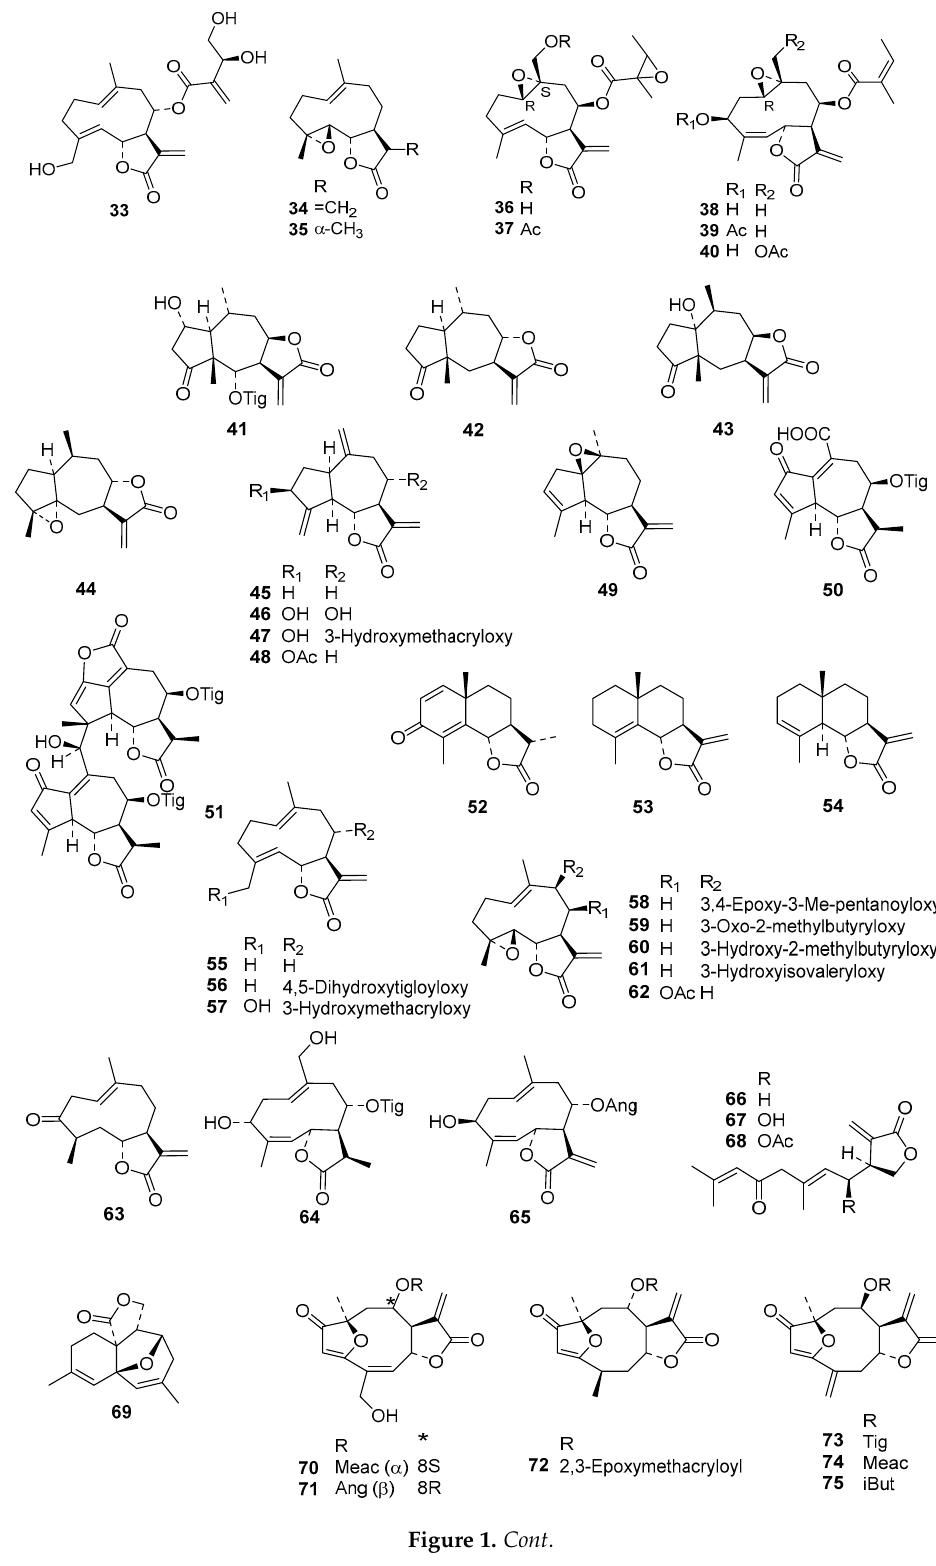
Figure 1. Cont. Structures of STLs used in the present QSAR analysis. Part 2 of the data set with Figure 1. Cont compounds included in our second QSAR study [9]. 41 – 43 : pseudoguaianolides; 44 – 51 : guaianolides and derivatives; 52 – 54 : eudesmanolides; 55 – 65 : germacranolides. 66 – 69 no subclass names; 70 – 75 : furanoheliangolides.